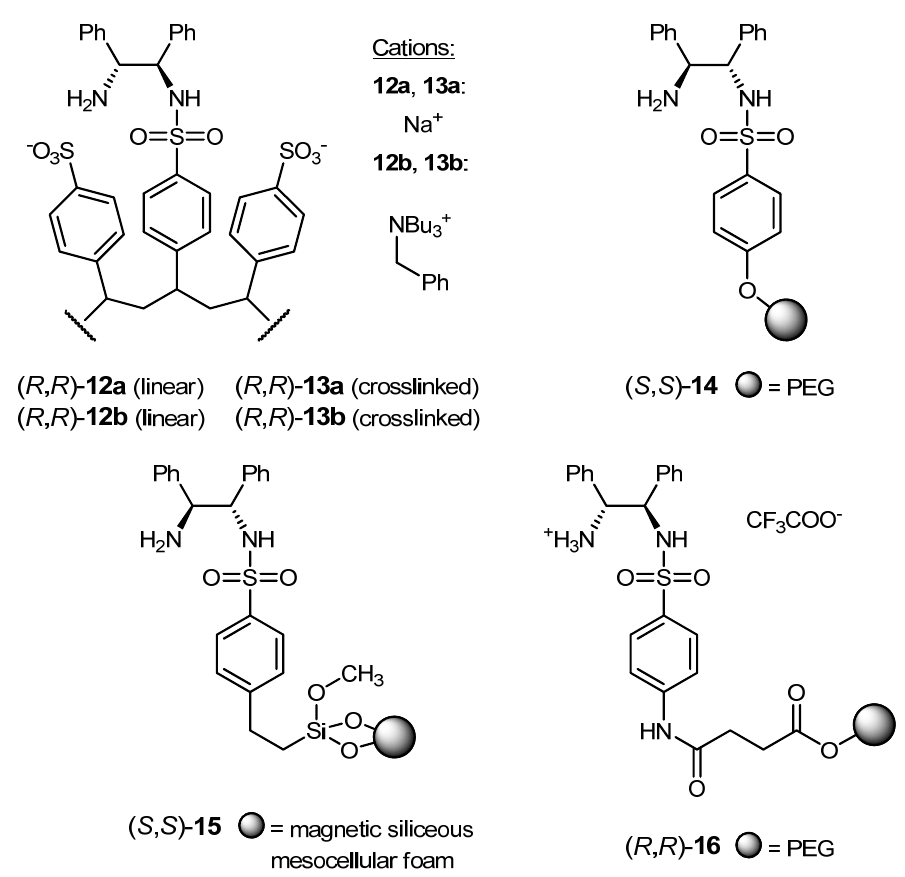
Figure 4. Immobilized TsDPEN-based ligands